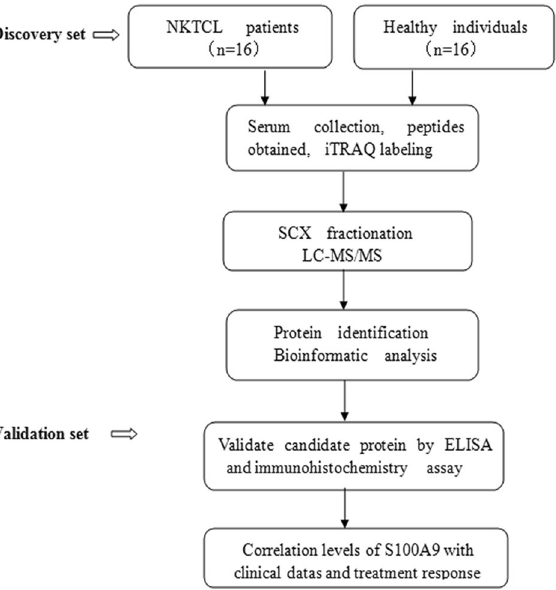
Figure 1. Work procedure for proteomic analysis to identify the differentially expressed proteins in serum between NKTCL patients and healthy